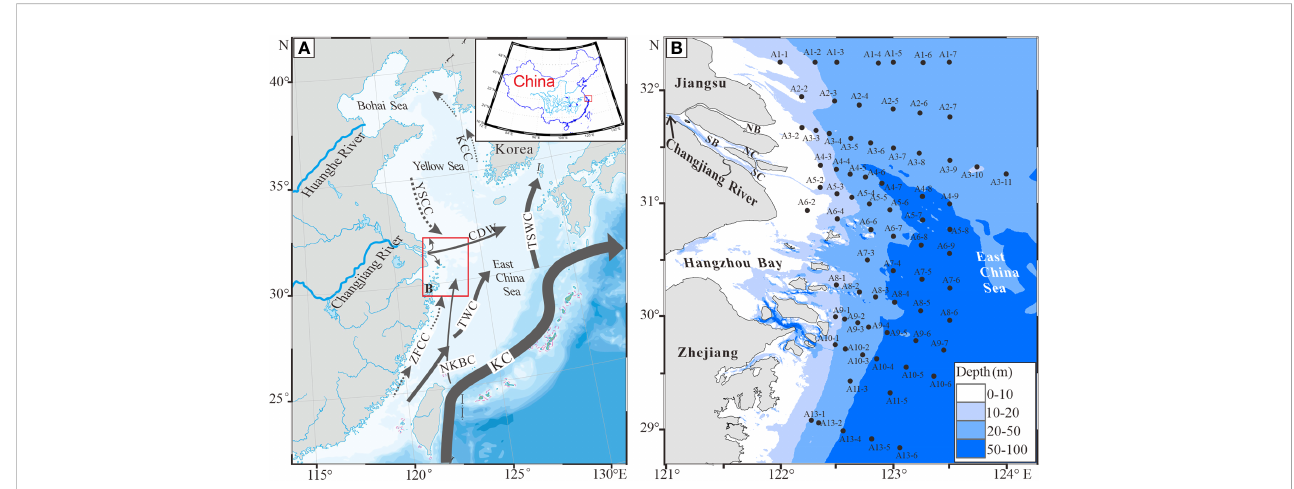
FIGURE 1 Schematic diagram of oceanic circulation patterns in summer in the eastern China seas (after Lee et al., 2002; Su and Yuan, 2005; Guan and Fang, 2006; Yang et al., 2012), and (B) distribution of 73 sampling stations off the Changjiang Estuary. Acronyms in (A) and their full expressions are KC, Kuroshio Current; NKBC, nearshore Kuroshio branch current; TSWC, Tsushima warm current; TWC, Taiwan warm current; YSCC, Yellow Sea costal current; ZFCC, Zhejiang-Fujian costal current; KCC, Korean coastal current; and CDW, Changjiang diluted water; those in (B) are NB, the North Branch; SB, the South Branch; NC, the North Channel; and SC, the South Channel of the Changjiang